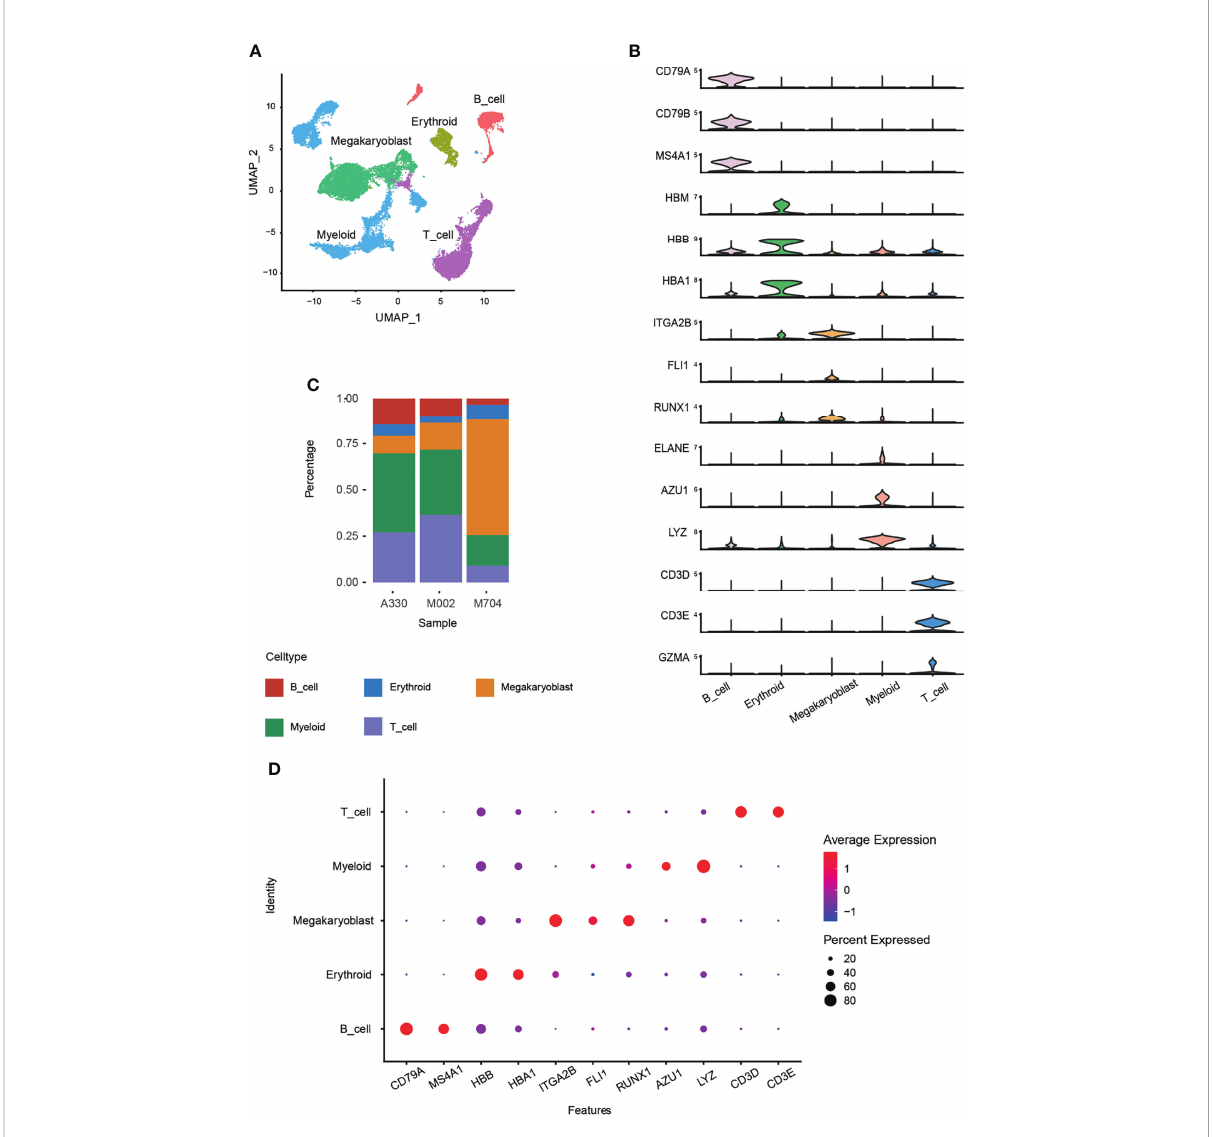
FIGURE 1 Identi fi cation of cell types using Seurat and Harmony packages. The bone marrow cells from three AMKL children were performed by scRNA- seq of the 10x genomics platform. A total of 24,387 cells were obtained after quality control. The batch effects were removed using the Harmony package. (A) The uniform manifold approximation and projection (UMAP) plot of the main cell types in AMKL samples. (B) The normal cell types were identi fi ed by classical marker genes, and the malignant cells, i.e., megakaryoblasts, were considered by canonical markers of megakaryoblastic lineage. (C) The proportion of the main cell types was calculated in each sample. (D) The dot plots show the average expression levels of signature genes in the main cell